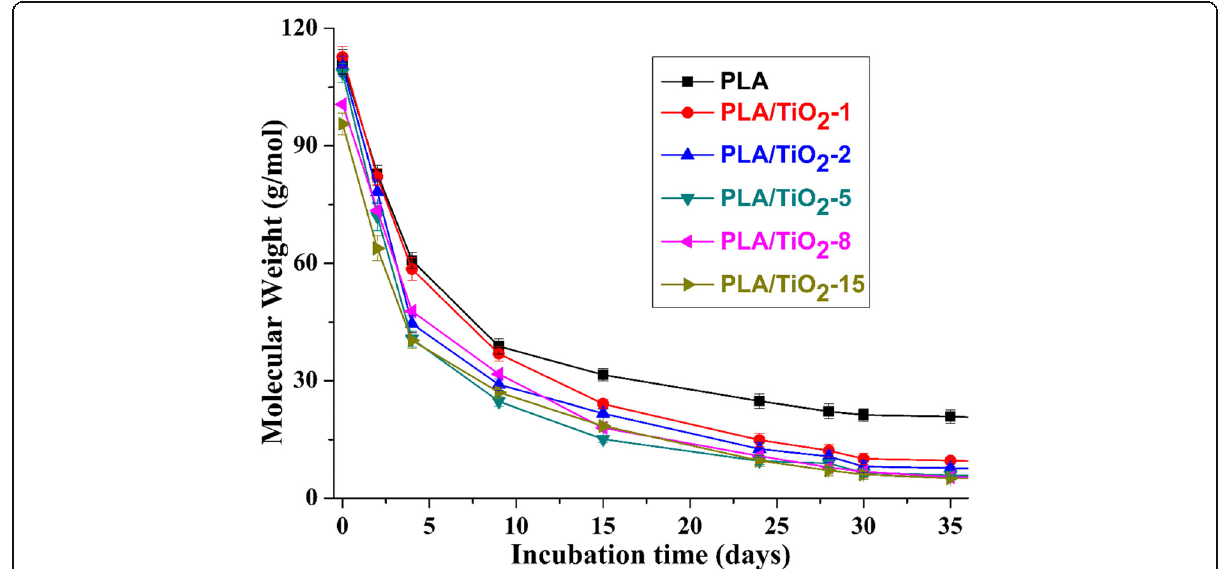
Fig. 6 Change of Mn as a function of time for pure PLA and PLA/TiO 2 nanocomposites